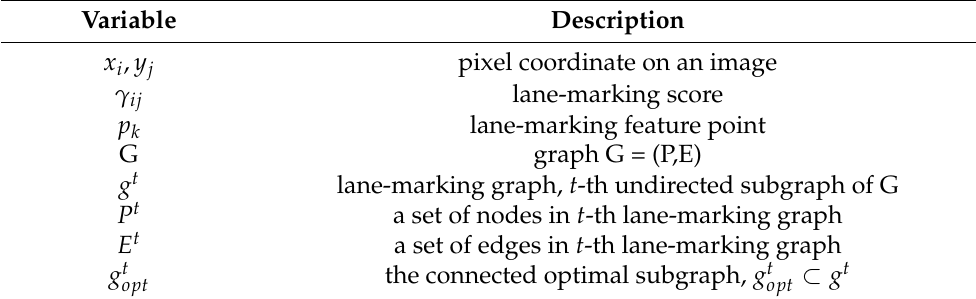
Table 1. Nomenclature table for principal components.